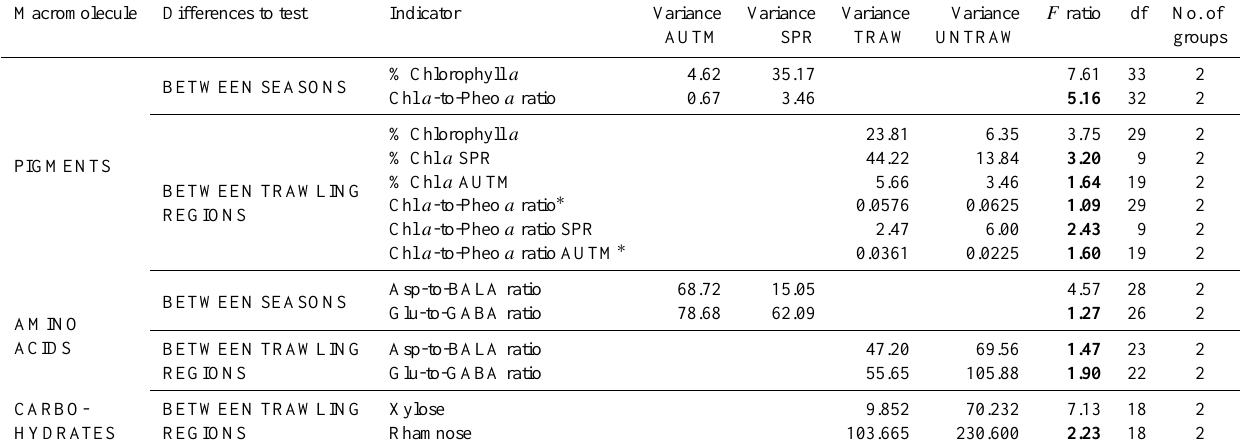
Table 2b. Results of the Hartley F max test. Homogeneity of variance is marked in bold. Transformed data are marked with an